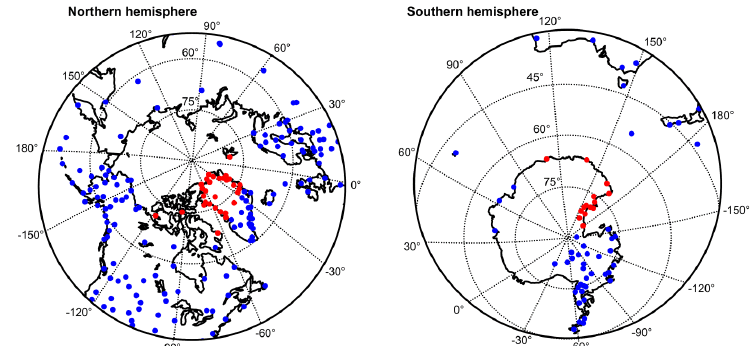
Figure 2. Distributions of GNSS permanent stations in both hemispheres (as seen from geomagnetic poles). Stations that were located over 75° of altitude-adjusted corrected geomagnetic (AACGM) poles). Stations that were located over 75 ◦ of altitude-adjusted corrected geomagnetic (AACGM) latitude were depicted with red dots. latitude were depicted with red